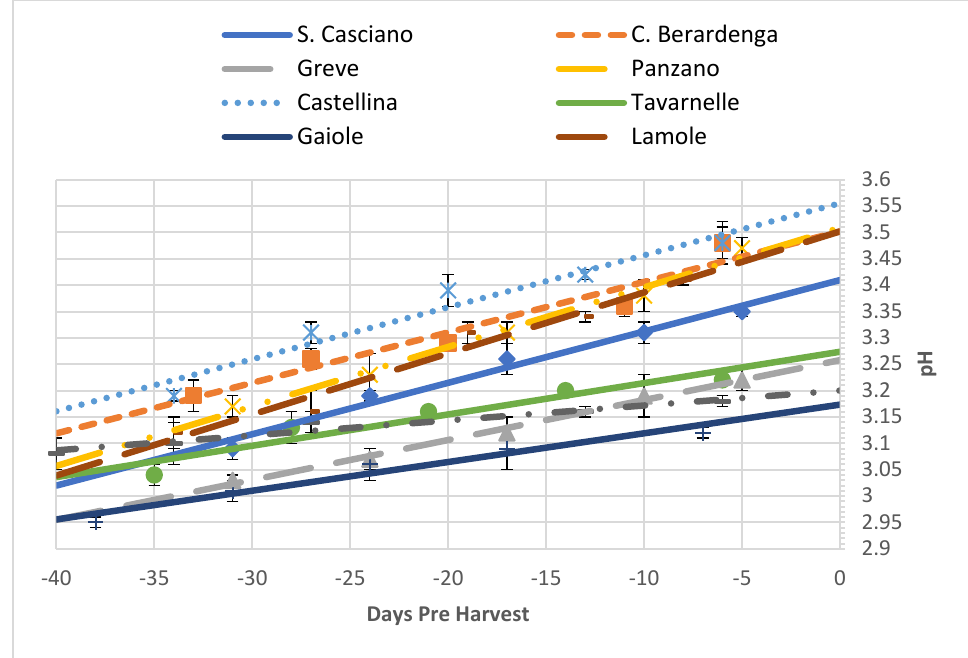
Figure 5. Trends of the pH in all the analysed vineyards as a function of time (expressed as negative days before the harvest). Each analytical point is reported with its 68% C.L. interval.